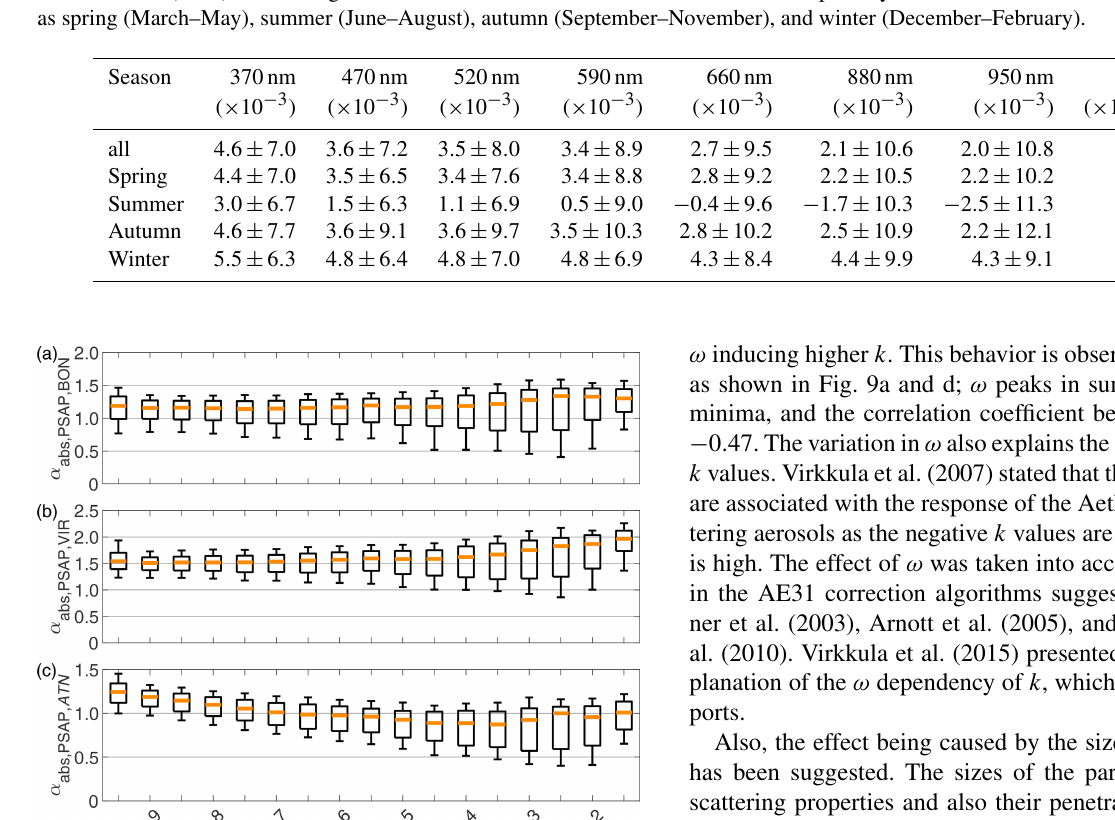
Table 4. The mean compensation parameters ( k ) and the wavelength dependency of k ( a k ) for the AE31 correction algorithm suggested by Virkkula et al. (2007). The average values are calculated over all the seasons but also separately for each season. The seasons were classified